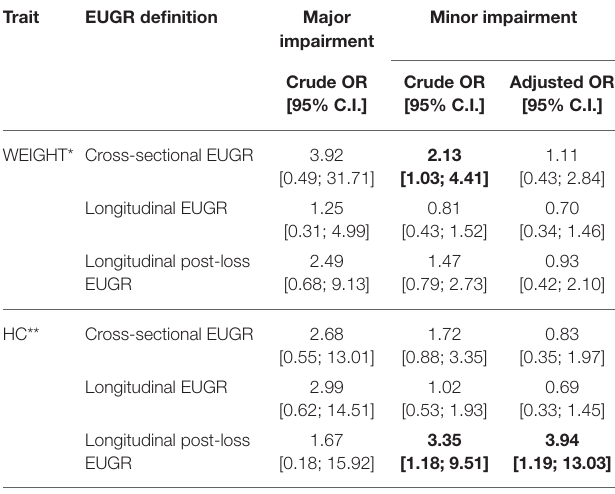
* analysis computed on 168 infants. ** analysis computed on 112 infants. Crude and adjusted Odd Ratio (OR) for morbidities during hospital stay, birth weight z- scores (EUGR for weight), birth HC z-scores (EUGR for HC), sex, and GA. Bold values represent statistically significant